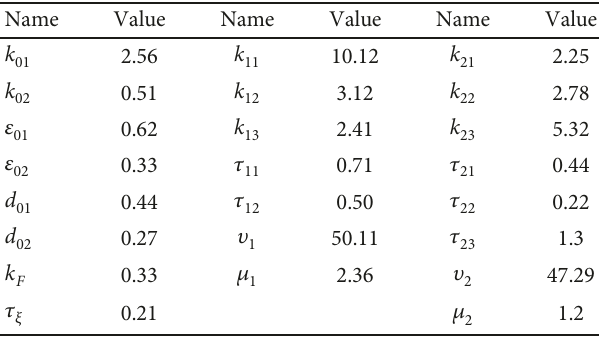
Table 3: Parameter optimization value of the IGC method for variable span